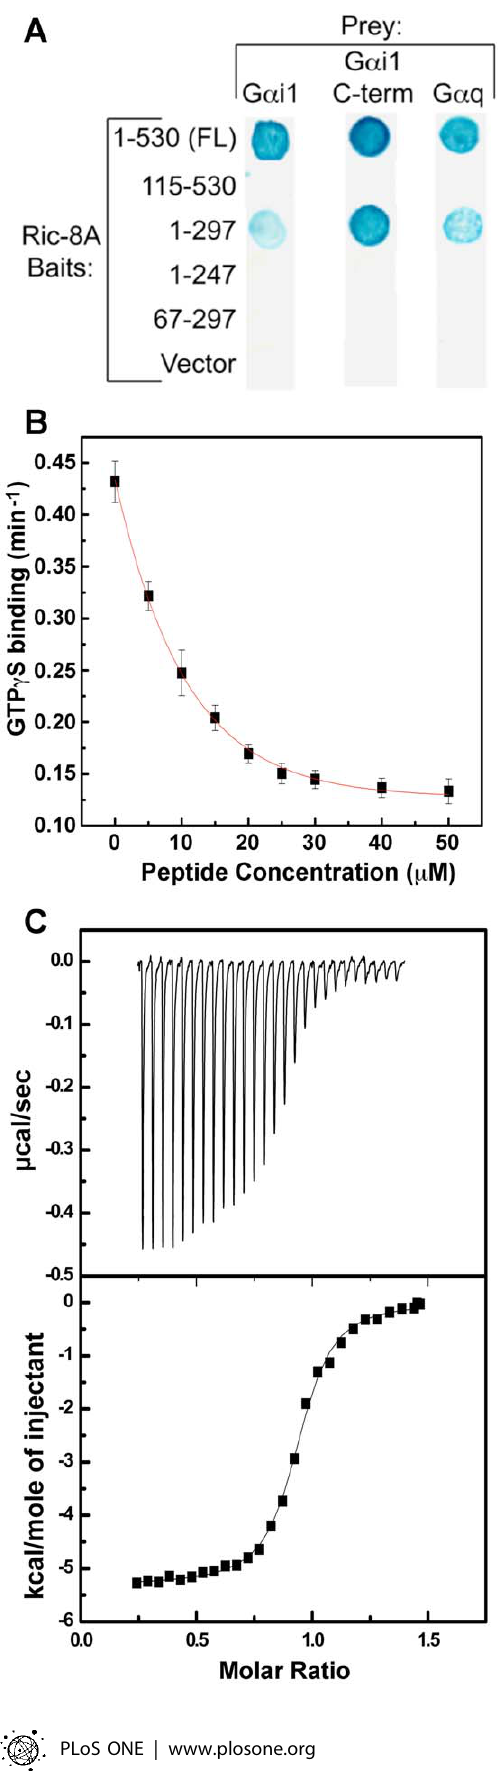
Figure 8. The carboxyl-terminus of G a i1 interacts with the amino-terminus of Ric-8A. (A) Yeast two-hybrid screen; prey clones encoding full-length G a i1, G a q and the carboxyl-terminal 81 amino acids of G a i1 were tested pair-wise using a b -galactosidase filter assay for interactions with the full-length Ric-8A bait (amino acids, 1–530 FL), and truncated Ric-8A bait constructs (amino acids: 115–530, 1–297, 1– 247, 67–297), and the empty prey vector. (B) Inhibition by G a i1C18, a peptide composed of the 18 C-terminal residues of G a i1, on Ric-8A- catalyzed binding of GTP c S to G a i1 was assayed by fluorescence emission from an endogenous G a i1 tryptophan. To 1 m M G a i1 N GDP in the presence of 1 m M Ric-8A, pre-incubated with different concentra- tions of G a i1C18, was was added a 10-fold excess of GTP c S and fluorescence at 340 nm upon excitation at 290 nm was monitored. GTP c S binding rates, obtained by fitting the time-dependent rise in fluorescence, plotted as a function of peptide concentration, yields an IC 50 of 23 m M for G a i1C18 inhibition of Ric-8A nucleotide exchange activity. Data points shown are the mean, and error bars indicate the standard deviation, for three separate determinations. (C) Isothermal titration calorimetric determination of binding of G a i1C18 to Ric-8A. Peptide (250 m M) was injected into a calorimeter cell containing 25 m M Ric-8A. The top panel shows the baseline corrected isotherm and the bottom panel indicates the fit of the same performed with a single binding site model, yielding a dissociation constant of 12 m M for binding of G a i1C18 to Ric-8A at 25 u C. The calculated enthalpy for the reaction was 2 5.3 kcal/mol with a stoichiometry (N) of